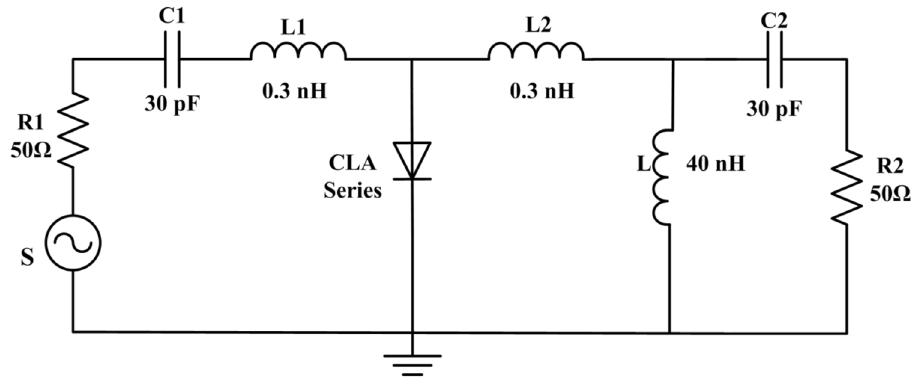
Figure 3. Circuit of the PIN limiter for